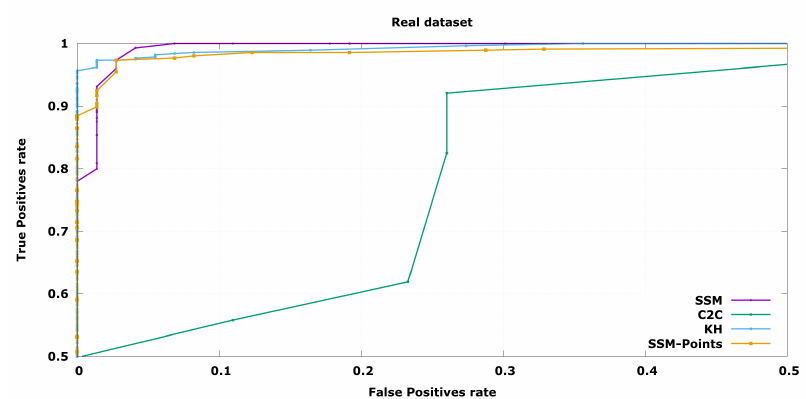
Figure 9. ROC curve for real objects classification (the objects in this set are barely distinguishable to the naked